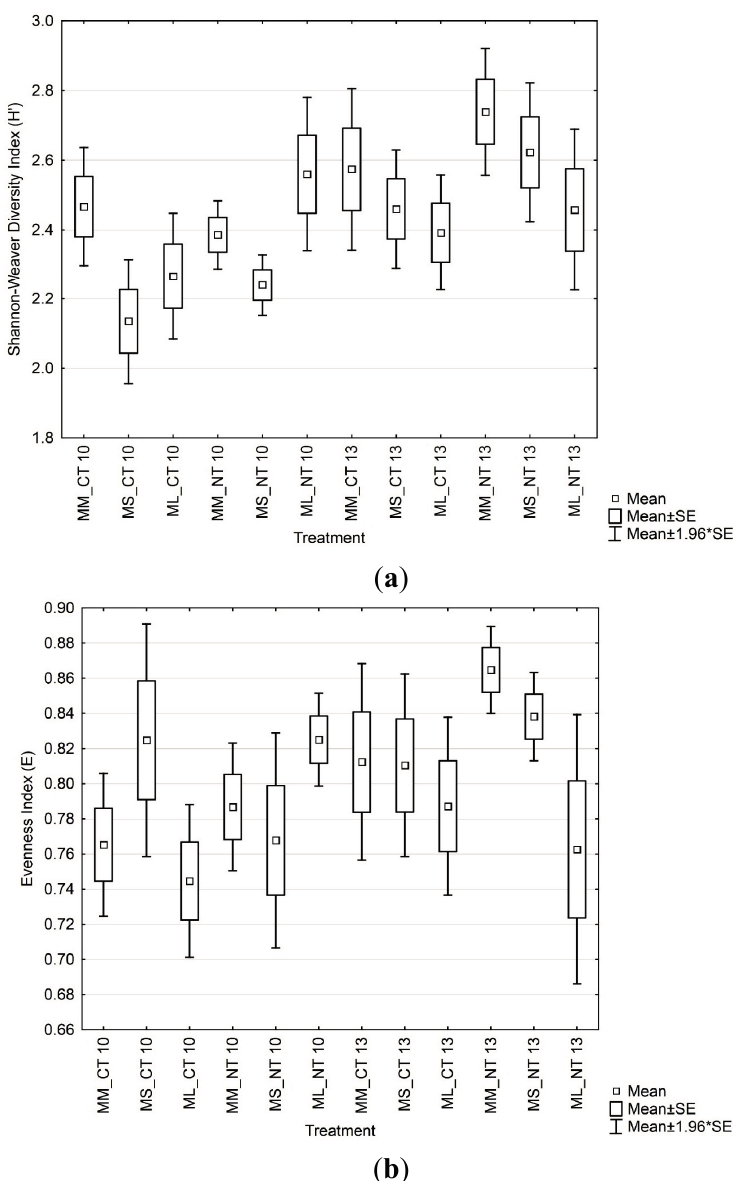
Figure 4. ( a ) Box and Whisker plots comparing the effect of cropping systems under CT and NT on soil microbial species richness (Shannon–Weaver Index) during the 2009/2010 and 2012/2013 planting seasons. ( b ) Box and Whisker plots comparing the effect of cropping systems under CT and NT on soil microbial species abundance (Evenness Index) during the 2009/2010 and 2012/2013 planting